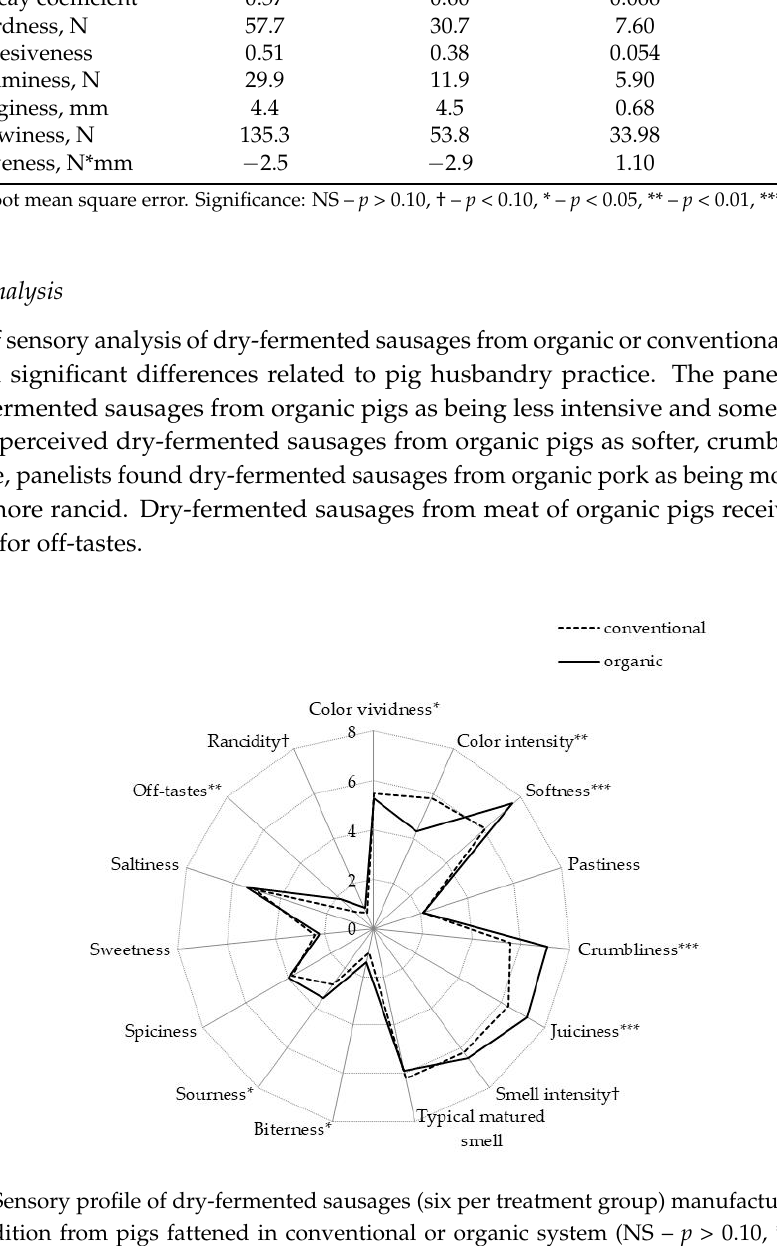
Figure 2. Sensory profile of dry-fermented sausages (six per treatment group) manufactured without nitrite addition from pigs fattened in conventional or organic system (NS – p > 0.10, * – p < 0.05, ** – p > 0.01, *** – p < 0.001)